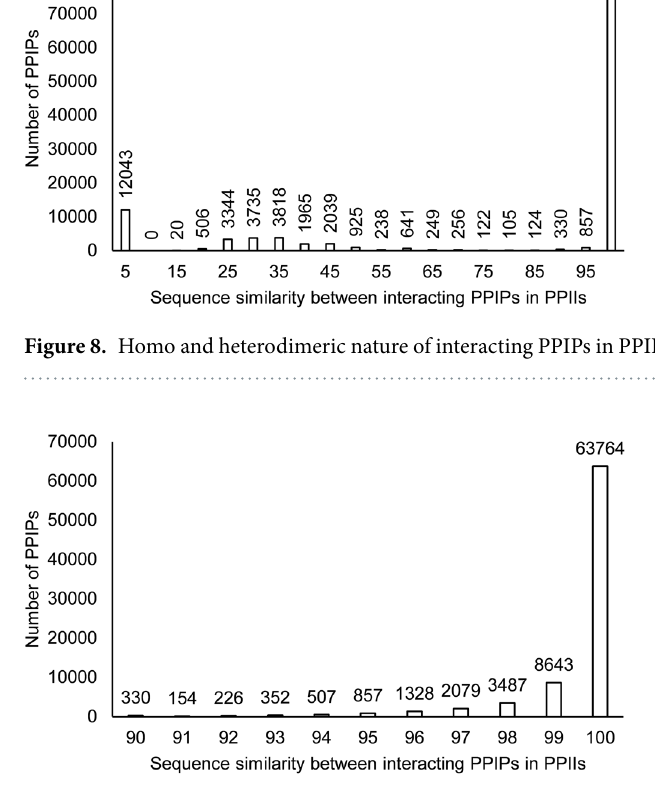
Figure 9. Zoomed-in view of complex destabilization on